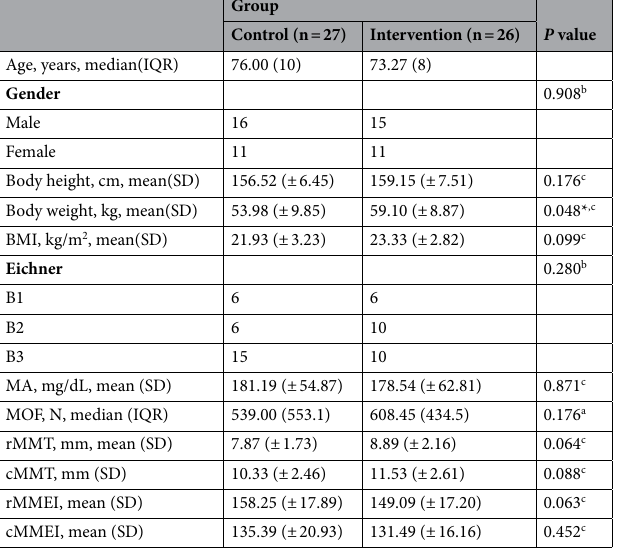
Table 1. Baseline characteristics of the participants (n = 53). IQR interquartile range, SD standard deviation, BMI body mass index, MA masticatory ability, MOF maximum occlusal force, rMMT masseter muscle thickness at rest, cMMT masseter muscle thickness during contraction, rMMEI masseter muscle echo intensity at rest, cMMEI masseter muscle echo intensity during contraction. * p -value < 0.05. a Mann–whitney U test. b Pearson’s χ 2 test. c Two sample t test.